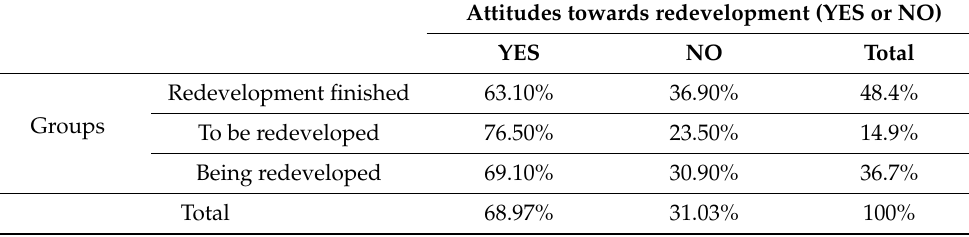
Table 5. Attitudes Towards